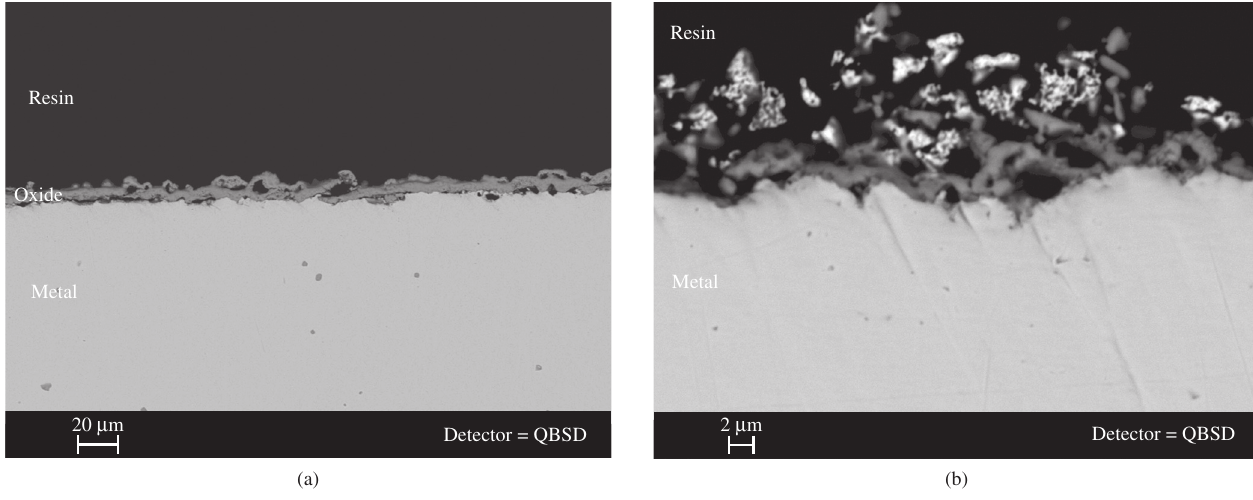
Figure 6. Cross section of Fe-20Cr after 15 cycles of oxidation in air at 1000 °C. a) Uncoated; and b) LaCrO